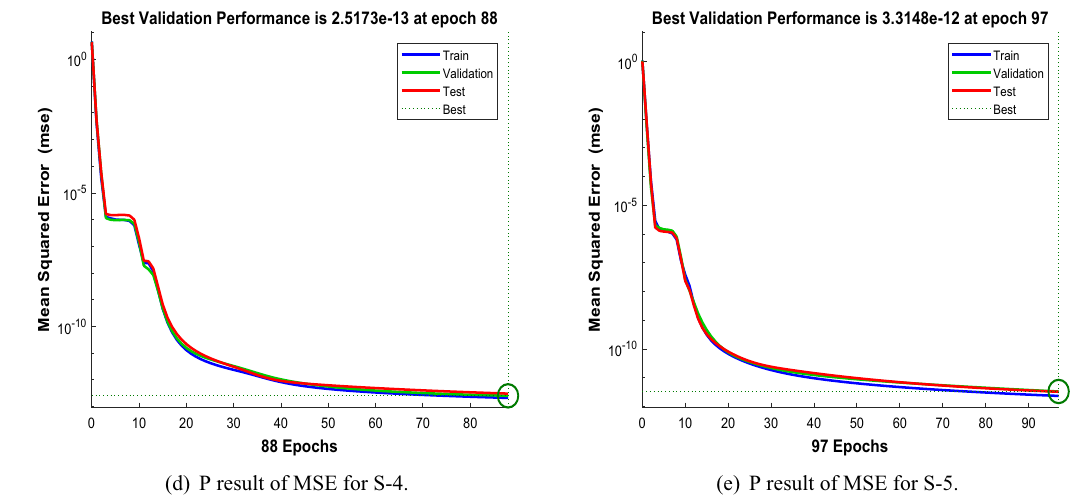
Figure 16. Performance (P) of the LMA-TNN for testing, validation, and training procedures of Case 4 in Reynolds